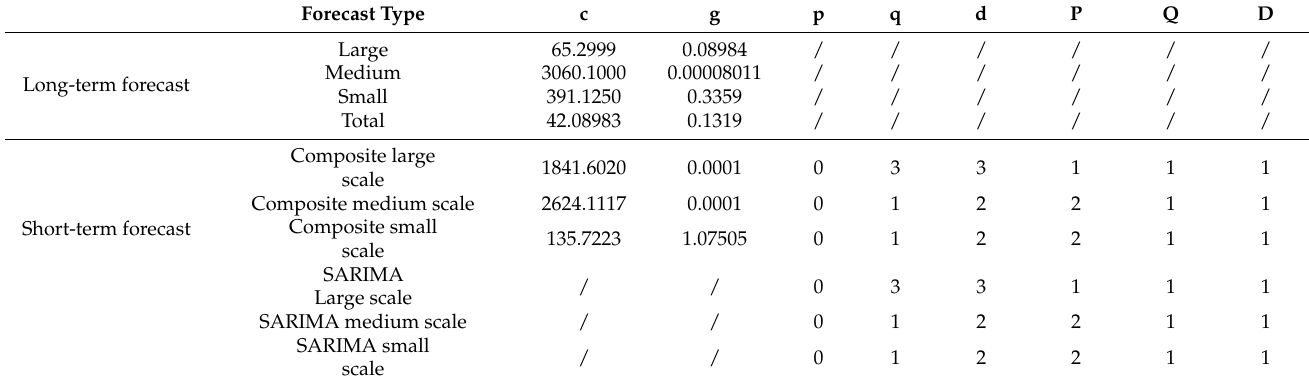
Table 5. Optimized parameters of the long-term prediction model and the short-term compound hybrid model.